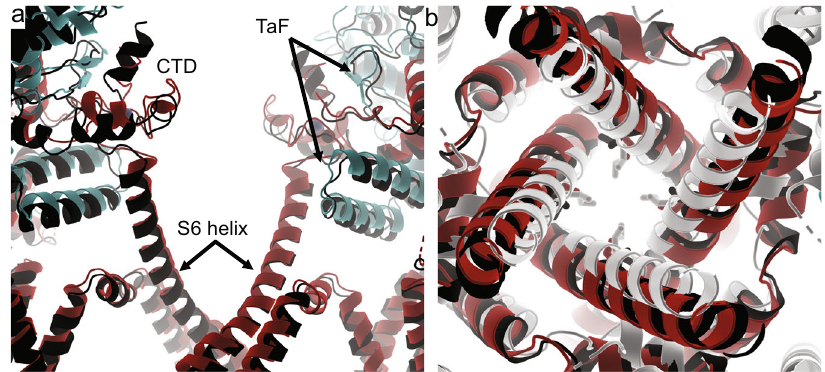
Fig. 7 ApoCaM binding to R615C pRyR1 results in a mix of open and closed channels. a Overall superposition of R615C pRyR1(colors) and open R615C pRyR1 + apoCaM (black), showing that, although both channels are in an open state, the CTD and the area contacting this (TaF = ‘ Thumb and Fore fi nger ’ domain) are in a different state. b Overall superposition of the inner pore of R615C pRyR1 (red) with closed R615C pRyR1 + apoCaM (white) and open R615C pRyR1 + apoCaM (black). The sidechain of Ile4935 is shown in